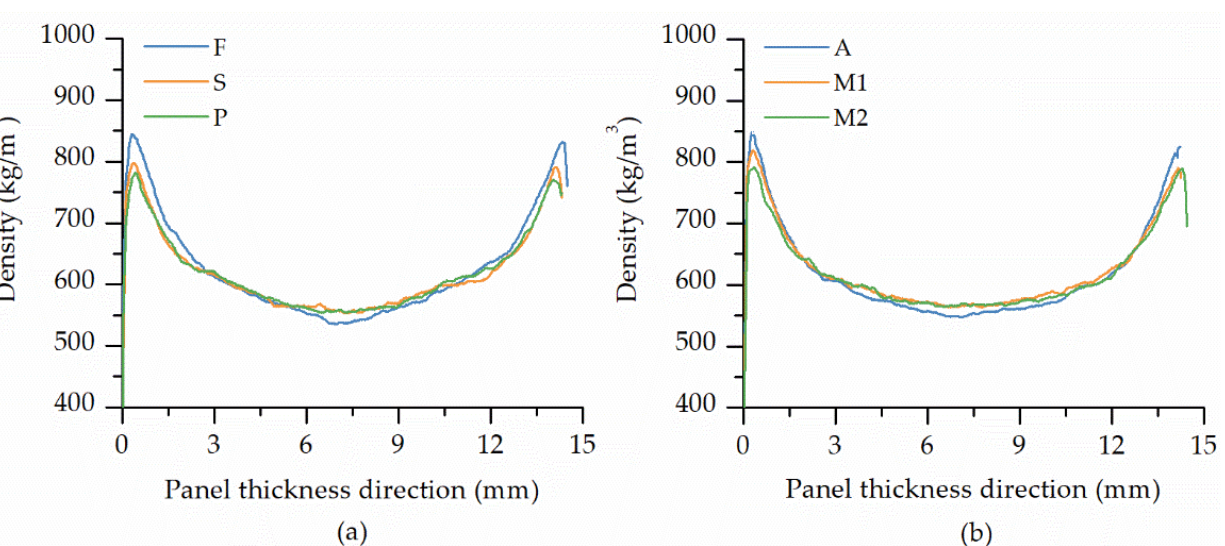
Table 3. Average property values for each species